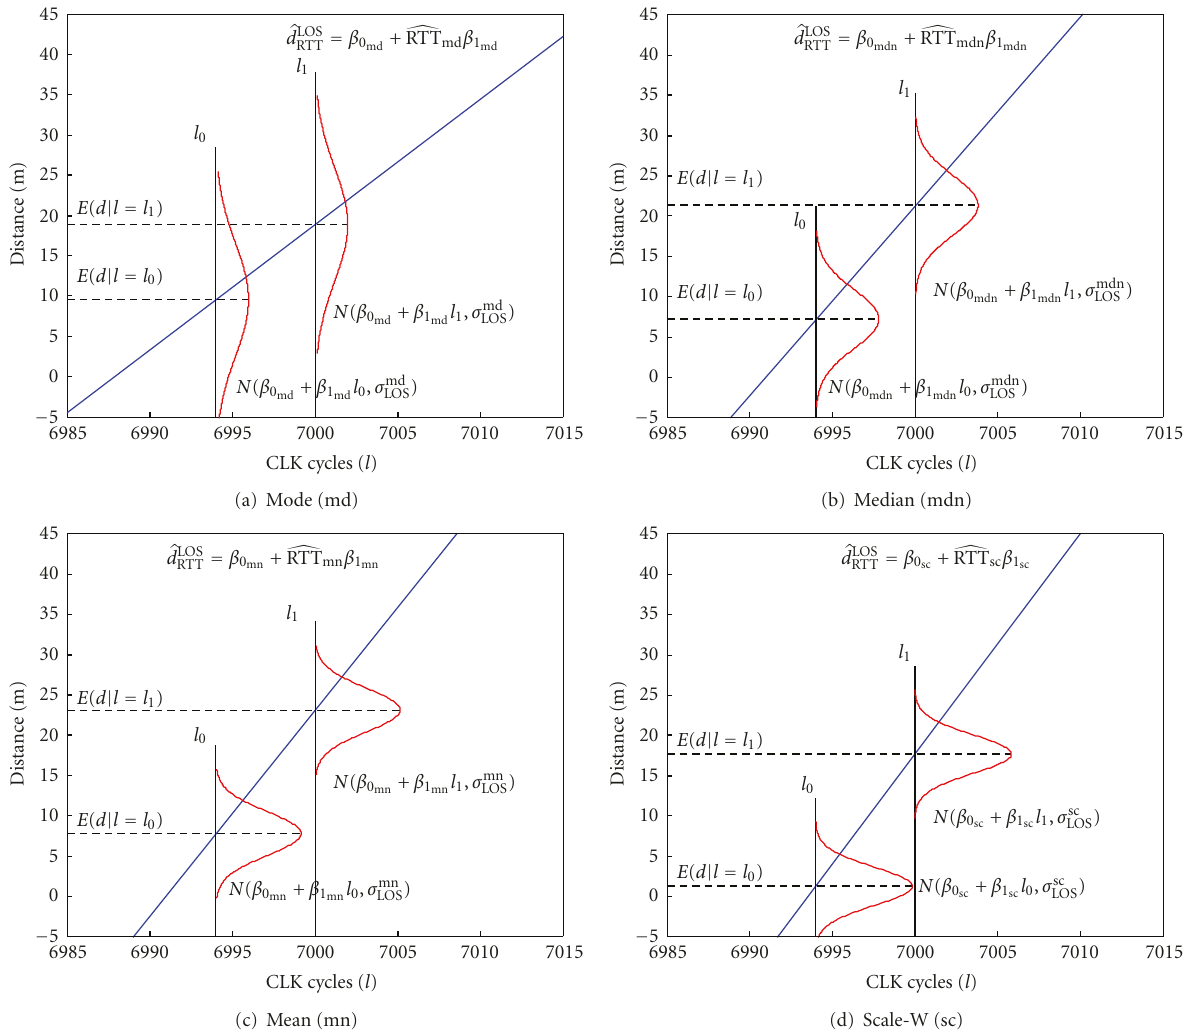
Figure 3: Robust linear regression function that best fits each location estimator to be analyzed: the mean, median, mode, and scale-W parameter, where each location estimator is computed from groups of 50 RTT measurements at each